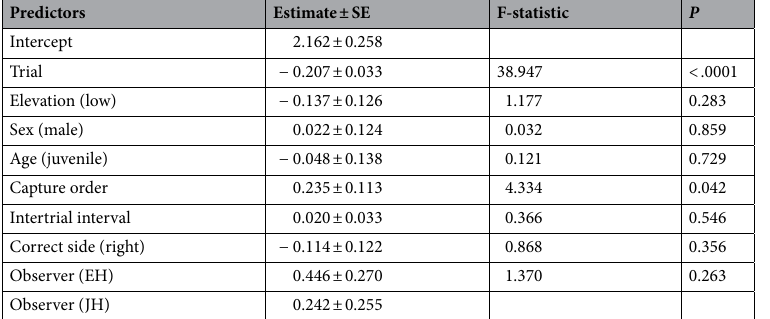
table: CI = [0.008, 10.434], odds ratio = 0.520, P = 1). Therefore, high and low elevation birds were both success- fully trained to remove pompoms covering food rewards and exhibited no apparent difference in motivation to consume the mealworms. Spatial memory.